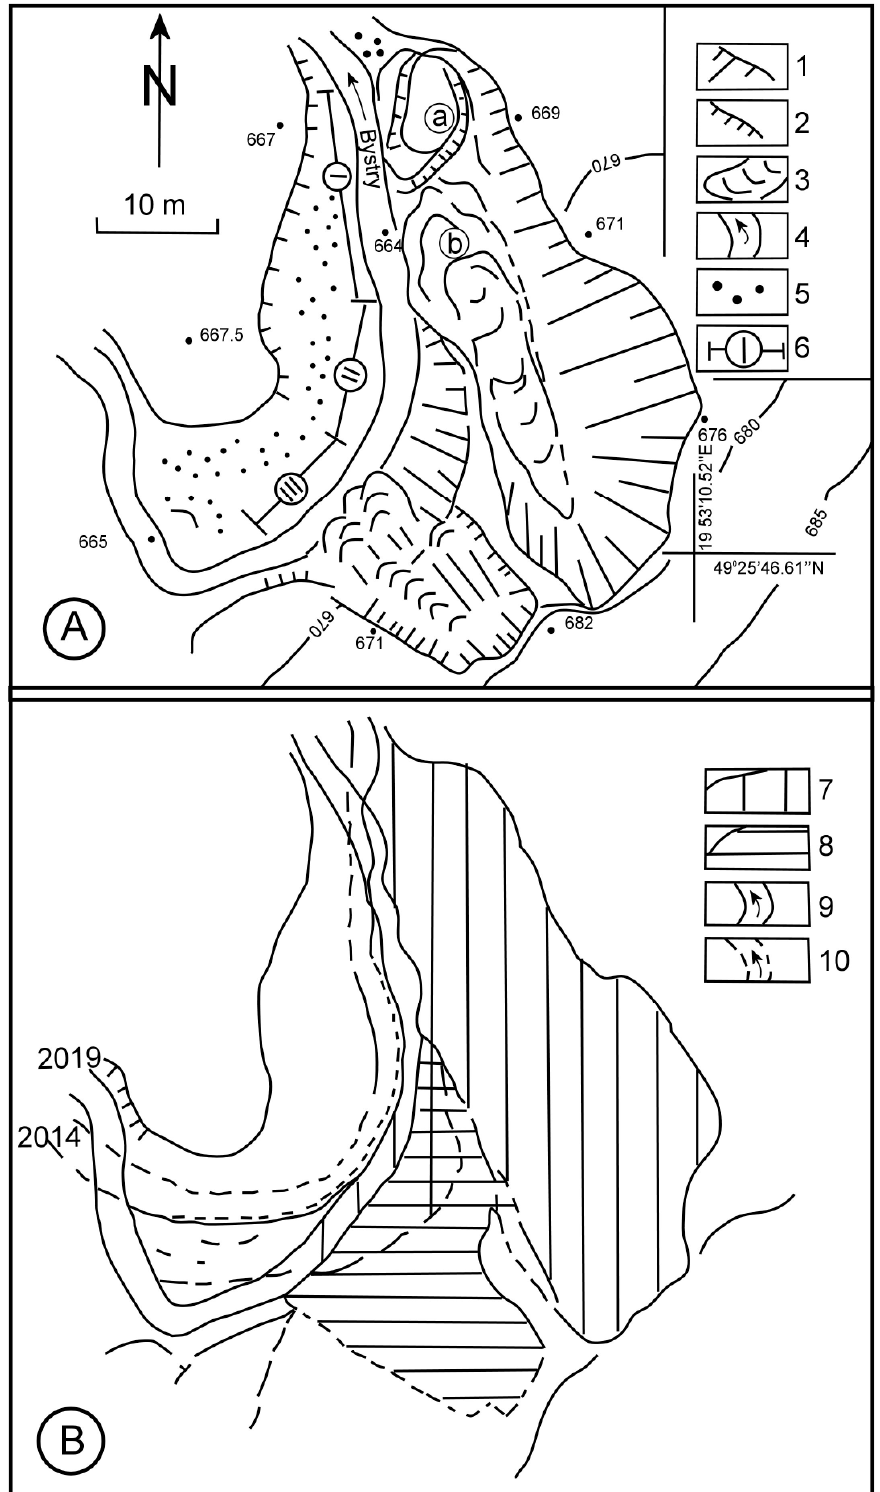
Figure 10. Transformation of the C-RCZ at site 3 in years 2013–2019; ( A )—plan of the landslide and river channel in 2019; ( B )—stages of landslide reactivation: 1—landslide main scarp, 2—erosional undercutting of the channel bank, 3—colluvial tongue, 4—river channel, 5—lateral gravel bar, 6— sections of the C-RCZ; 7—landslide surface in 2013, 8—surface of landslide rejuvenation in